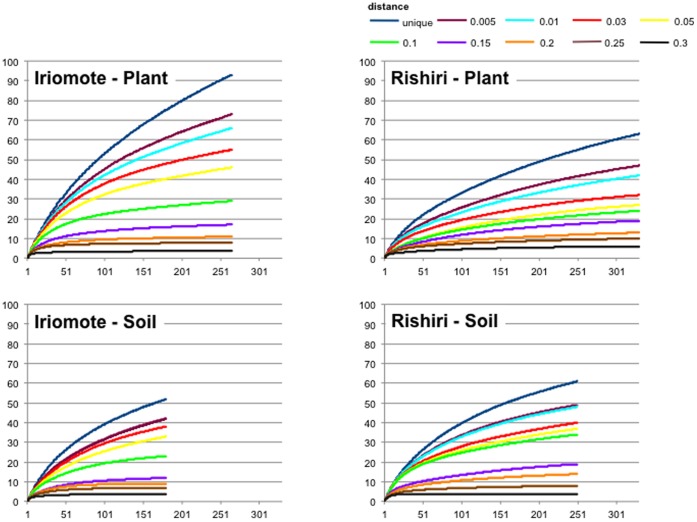
Comparison of rarefaction curves among plant and soil samples of Iriomote and Rishiri Islands.Rarefaction values were obtained using the MOTHUR program [25] and data of some particular thresholds of a respective group are plotted. Numerals in the boxes indicate the value of chao (chao_lci – chao_hci) of distances unique, 0.005, 0.03 and 0.01 from the top in the respective group.